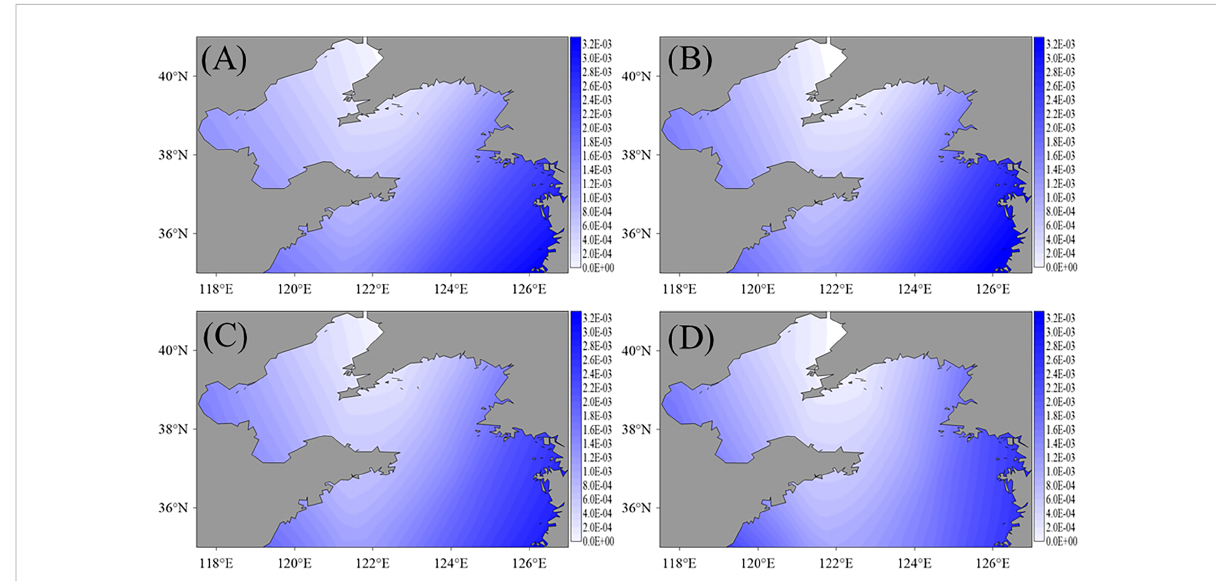
FIGURE 8 The BFC values after data assimilation from EXP 2 (A) , EXP 3 (B) , EXP 4 (C) and EXP 5 (D) with different observational